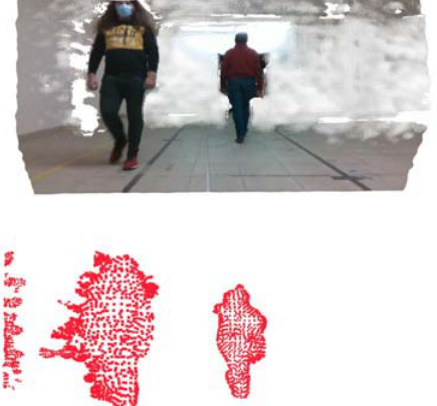
Figure 5. Moving obstacle detection (pedestrians walking in opposite directions). In this test, the AGV was stationary. ( Top ): original point cloud; ( Bottom ): detected clusters.